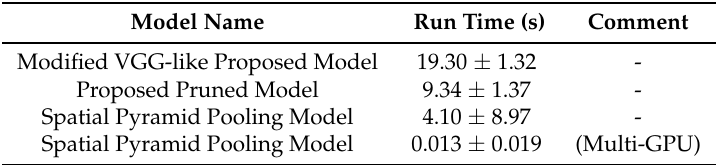
Table 8. Deep convolutional network classification in real-time (mean runs, 10 loops each); containing four sequence characters/finger-spelling.